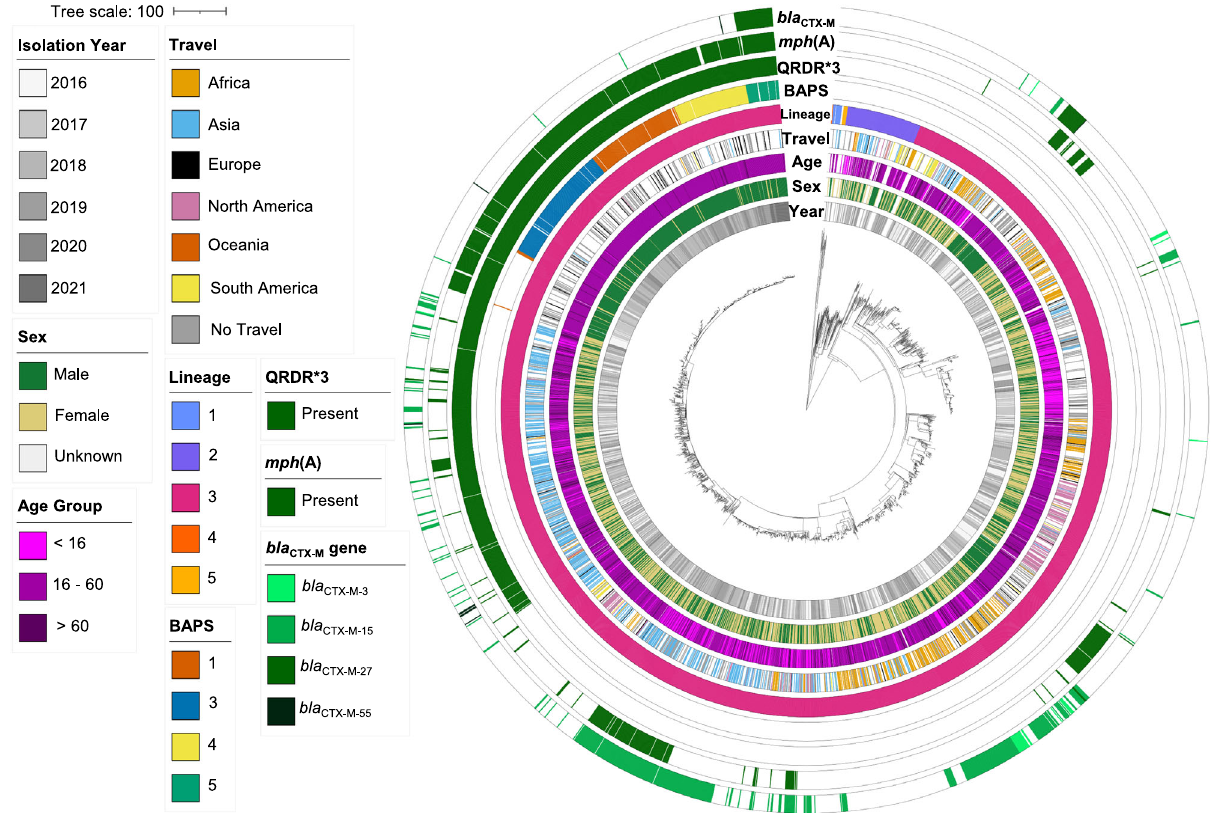
Fig. 1 | The emergence of an XDR S. sonnei outbreak in the United Kingdom. A cgMLST dendrogram(midpoint rooted) ofclinical isolates from theUK( n =2,820) and genomic subtype references ( n =120) with the scale bar indicating distance in cgMLST alleles. Metadata tracks show patient and genomic features for isolates coloured according to the inlaid keys. Speci fi cally, from inner to outer, the patient data comprises: year of isolation, patient sex,age group,and travelhistory(for UK